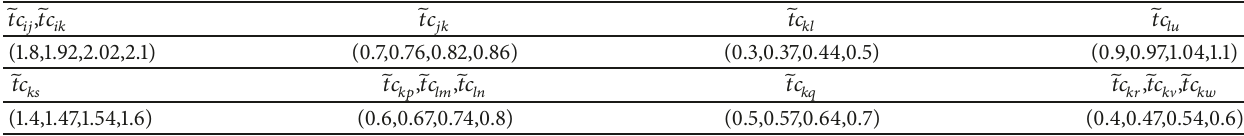
Table 9: Unit transportation cost of each item (yuan/ton ⋅ km).